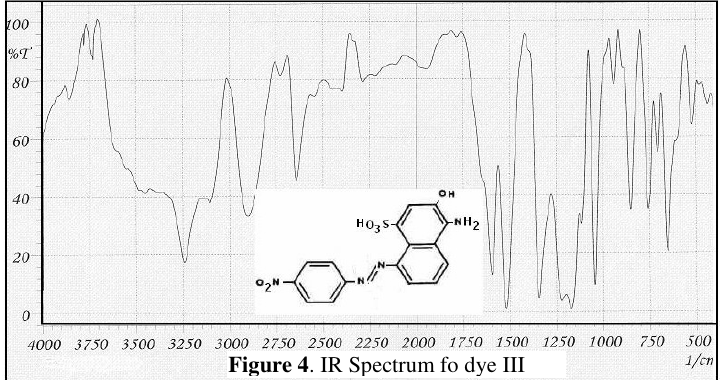
Figure 4 . IR Spectrum fo dye